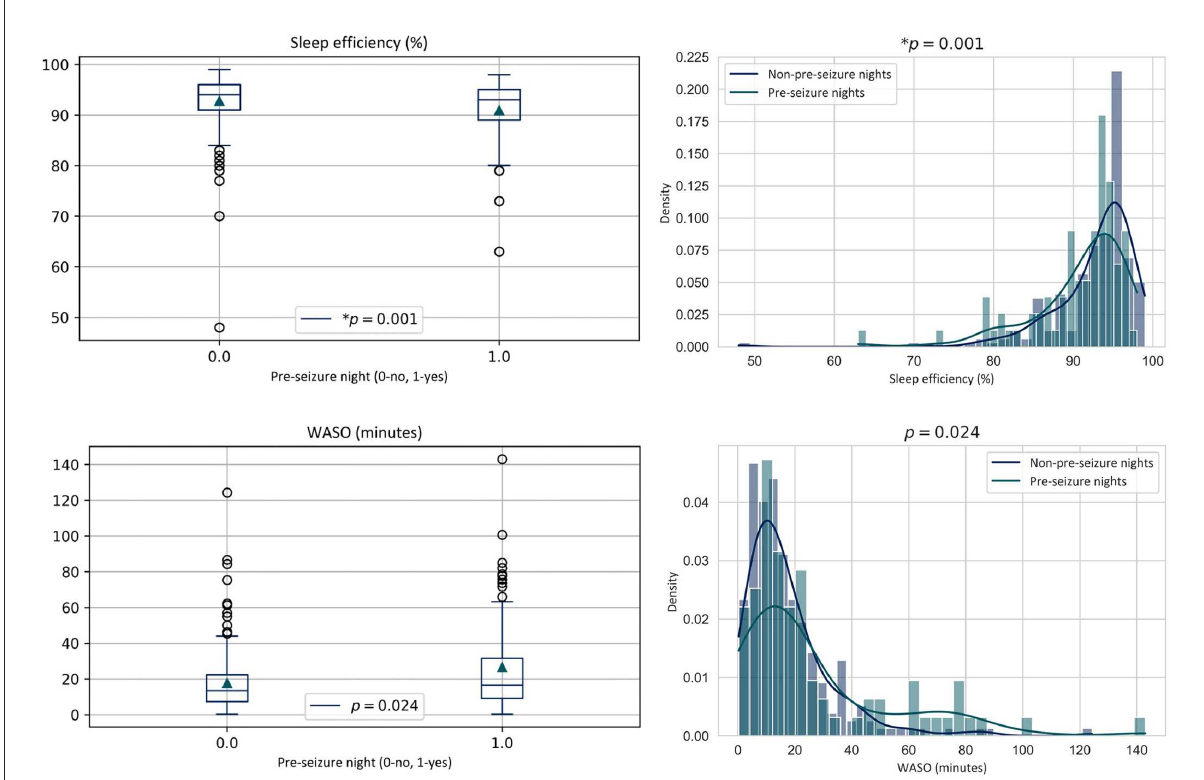
FIGURE4 Sleep metric distributions of all nocturnal recordings followed by at least one clinical seizure occurring within the 24h following wake (Pre-seizure) vs. those where no seizure occurred within the 24h following wake (Non-pre-seizure). WASO, time in wake after sleep